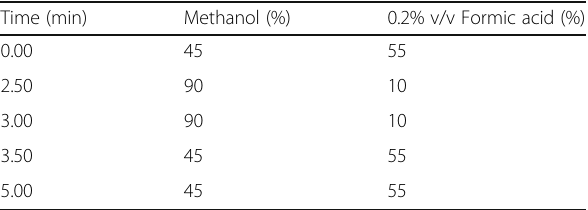
Table 1 The gradient eluting pattern for cucurbitacin B determination by using